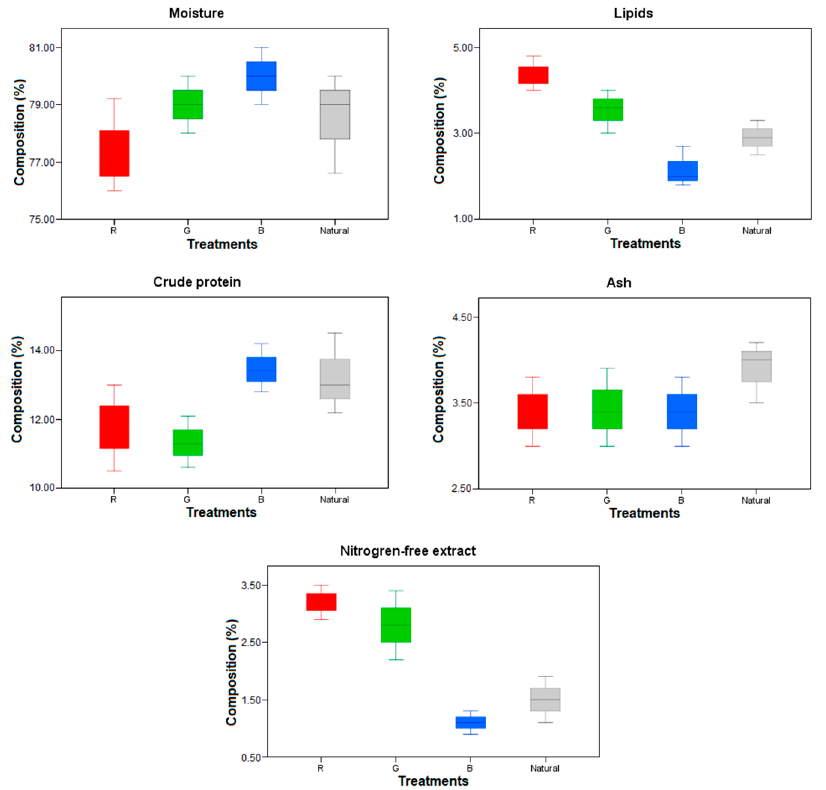
Figure 4. Box-and-whisker plots showing the nutritional composition of the fish (%).